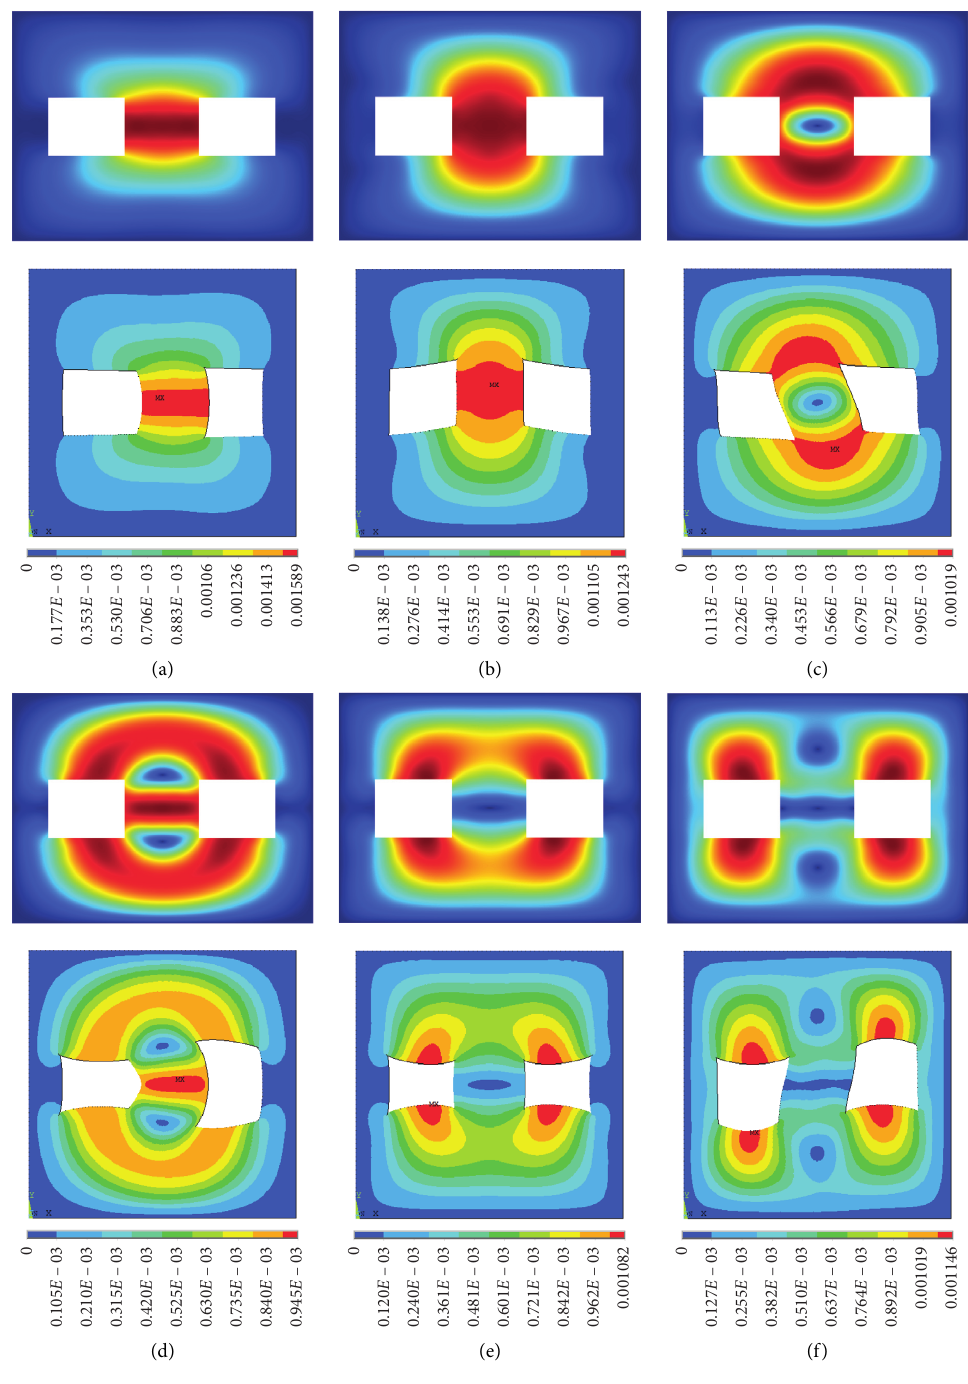
Figure 9: The first six mode shapes for the square plate with double inner cutouts. (a) The first mode; (b) the second mode; (c) the third mode; (d) the fourth mode; (e) the fifth mode; (f) the sixth mode. Upper: the present results; lower: the ANSYS